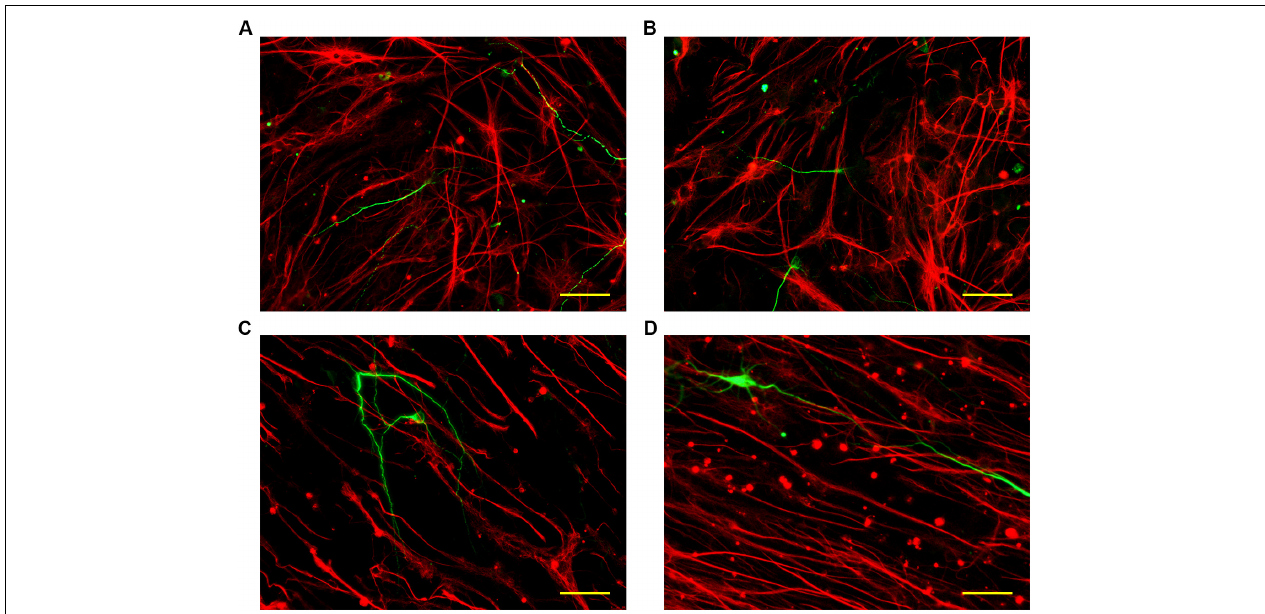
FIGURE 5 | Differentiation of neural stem cells. The fluorescent images of neurons and glial cells cultured on the PVDF control (A) , on the inverse opal substrate (B) , on the 3 × stretched substrate (C) , and on the 6 × stretched substrate (D) . Scale bars are 40 µ